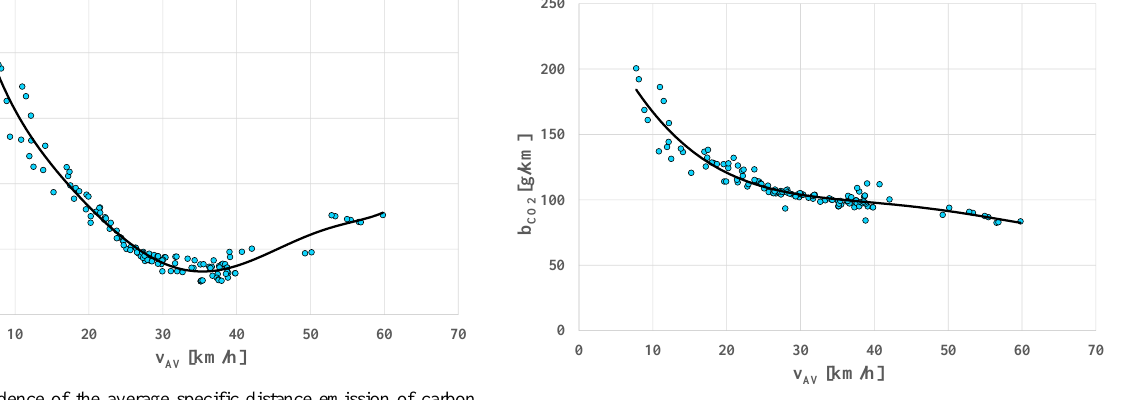
Fig. 16. Dependence of the average specific distance emission of carbon dioxide on the average vehicle velocity in the Malta test